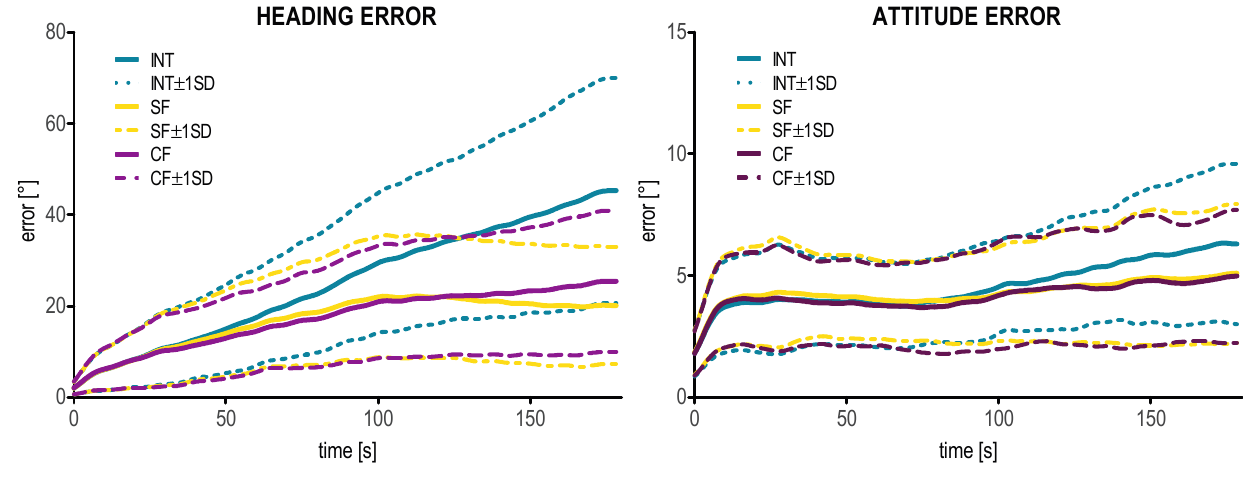
Figure 5. Heading and attitude errors ( Δθ ) of the INT, SF and CF methods plotted as a function of time for the locomotion task. The mean ± one standard deviation (SD) curves over the six participants are reported. Note the different scale of the axes of the ordinate in the two